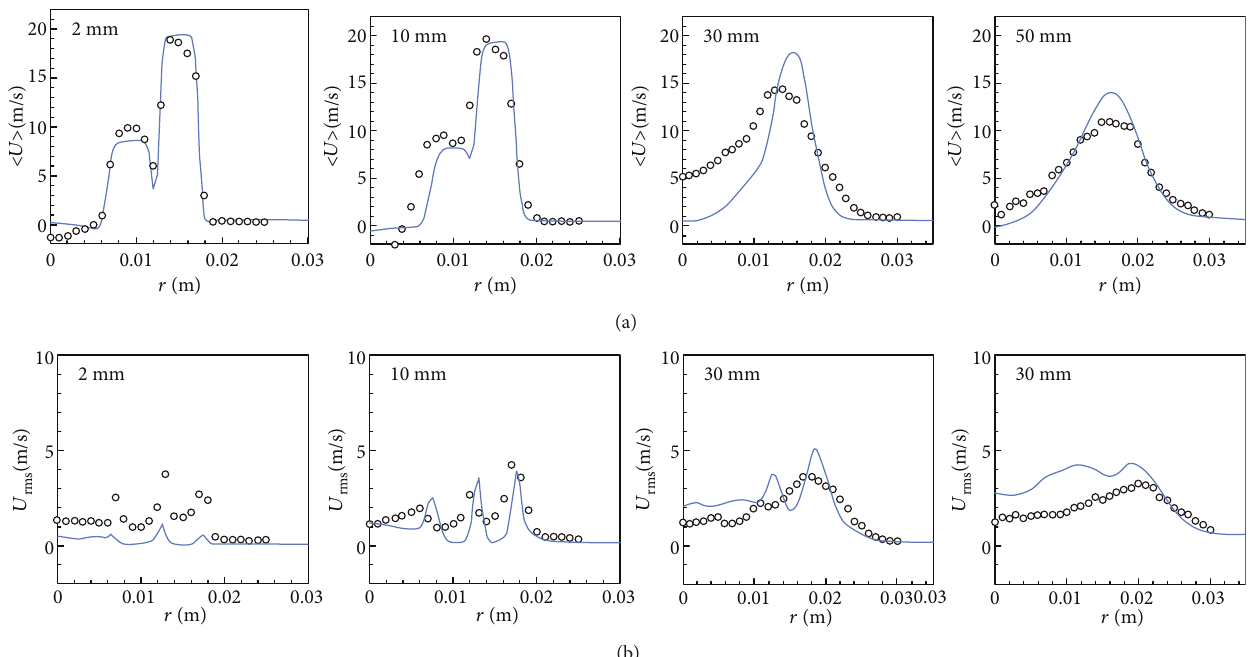
Figure 5: Comparison of mean (a) and rms (b) axial velocity at Δ X = 2mm , 10 mm, 30 mm, and 50mm (circles, experimental results; solid line, LES results).